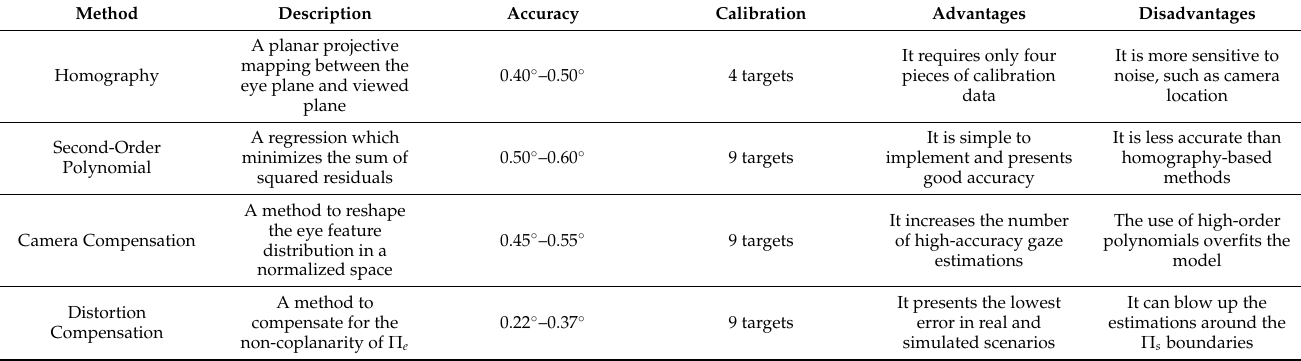
Table A1. A comparison of traditional interpolation-based gaze estimation methods and proposed compensation methods